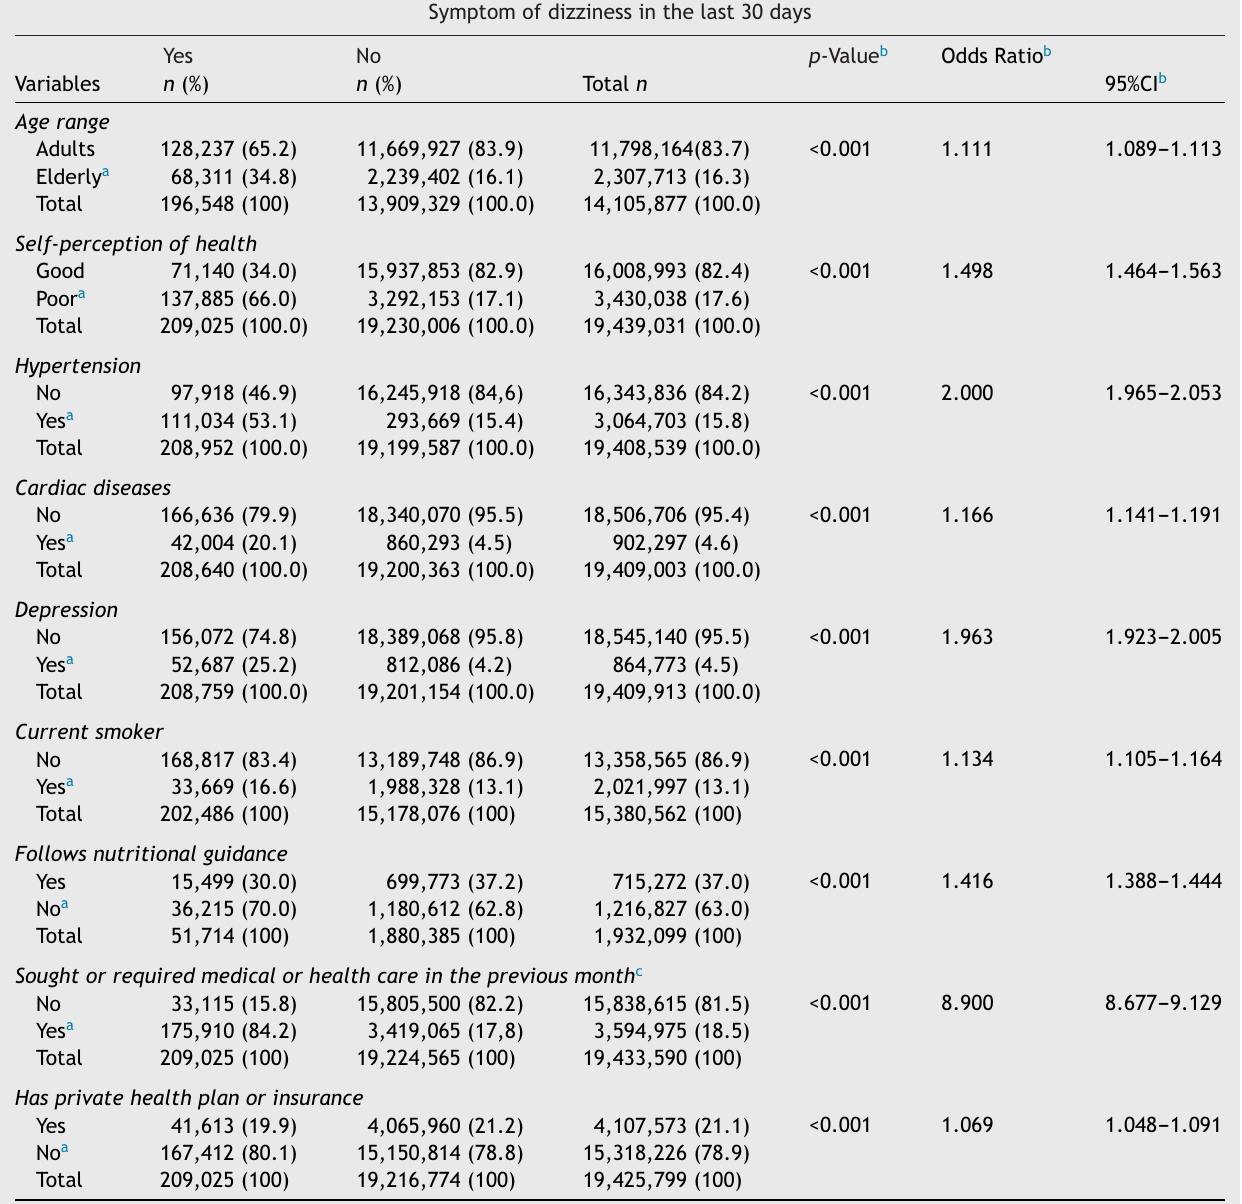
Table 2 Multivariate binary logistic regression of factors associated with the presence of dizziness in the 30 days preceding the interview of PAD-MG,